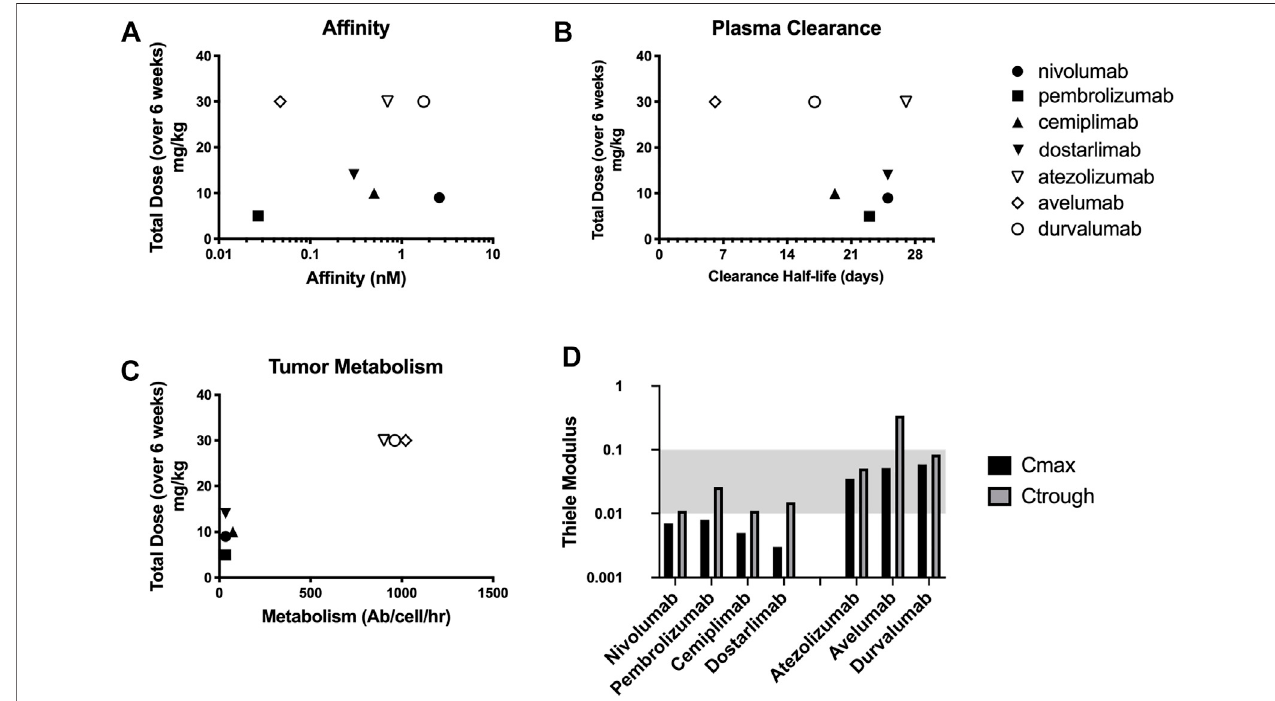
FIGURE3| Checkpointinhibitorsvarywidelyintargetaf fi nity (A) andplasmaclearance (B) relativetodosing.However,thedosescorrespondmorecloselywiththe local tumor degradation/metabolism of the drug (C) . Thiele Modulus of 7 different checkpoint inhibitors calculated at both C max and C trough showing supersaturating doses (D)